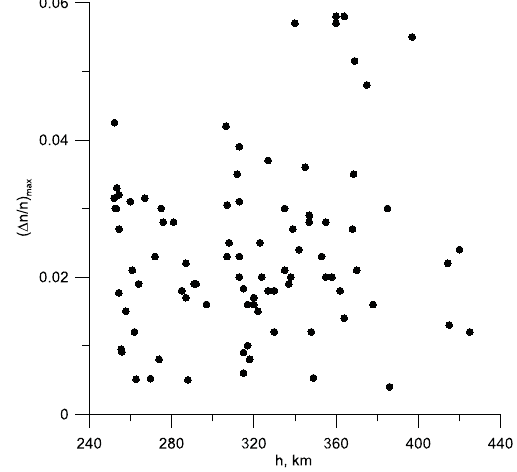
Figure 5. AGW amplitudes at different altitudes according to DE2